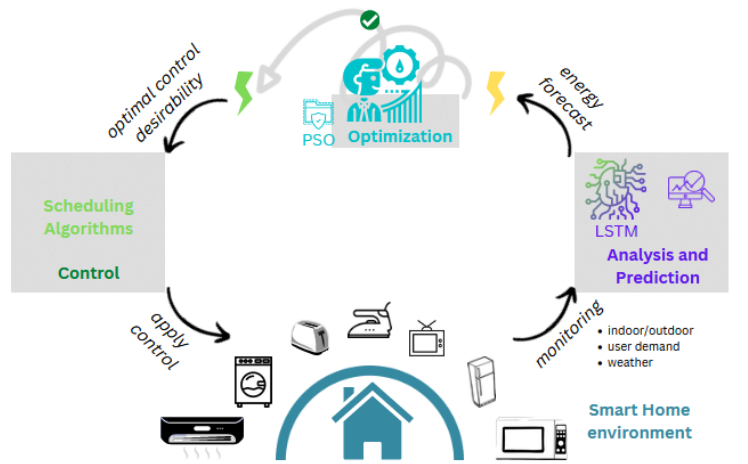
Figure 1. Complex Problem-Solving (CPS) environment: analysis, prediction, optimization, schedul- ing, and